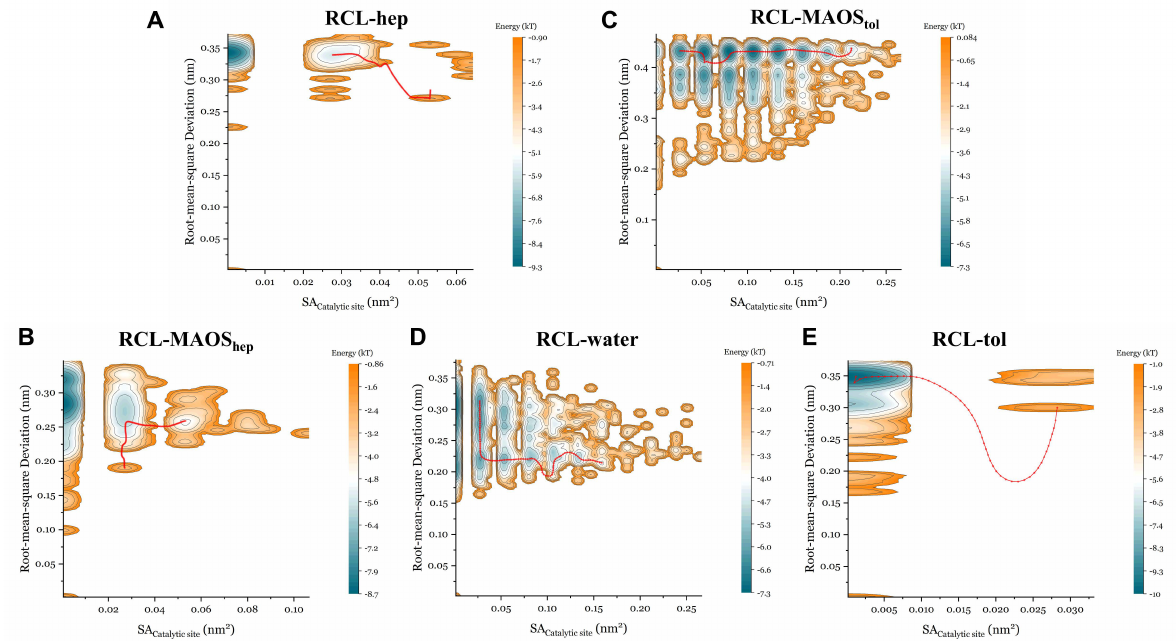
Figure 7. Energy landscape analysis of RCL with correlation to RMSD and the solvent accessible area of catalytic residues in the n-heptane system ( A ), in the MAOS hep system ( B ), in the MAOS tol system ( C ), in water ( D ) and in the toluene system ( E ). Energy E(x) was calculated through the Boltzmann distribution. Energy landscape analysis was conducted according to the probability density P(x). Each trajectory was sampled every 100 ps in the EL analysis. The red line represents the minimum energy